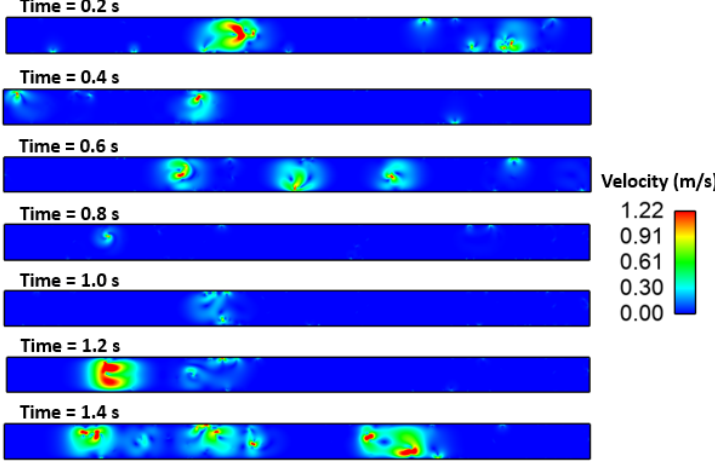
Figure 14. Velocity field of inclusion and molten steel (S: 100